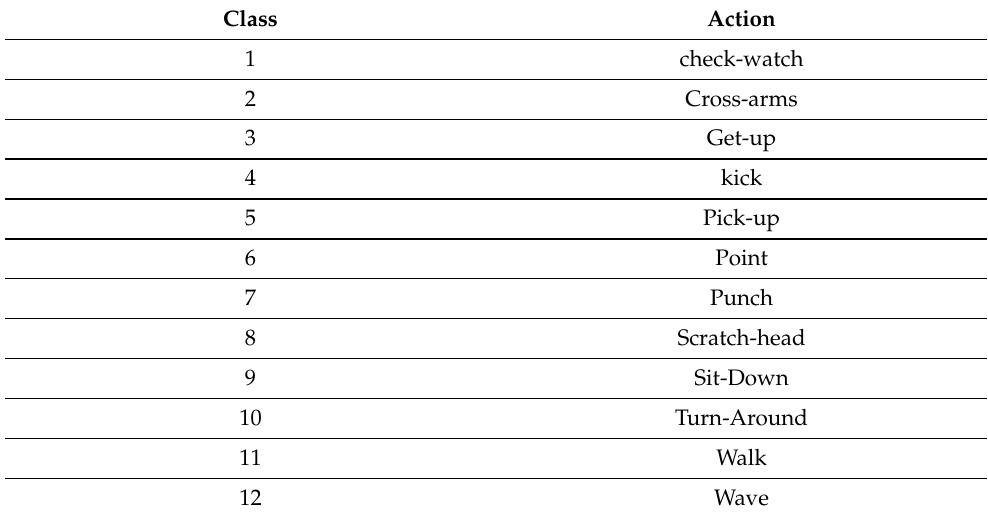
Table 3. List of actions from IXMAS Dataset.